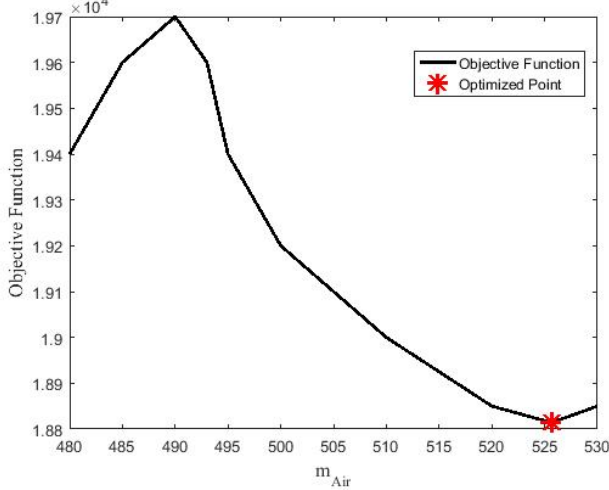
Figure 4. Variations in the objective function with the air flow rate.